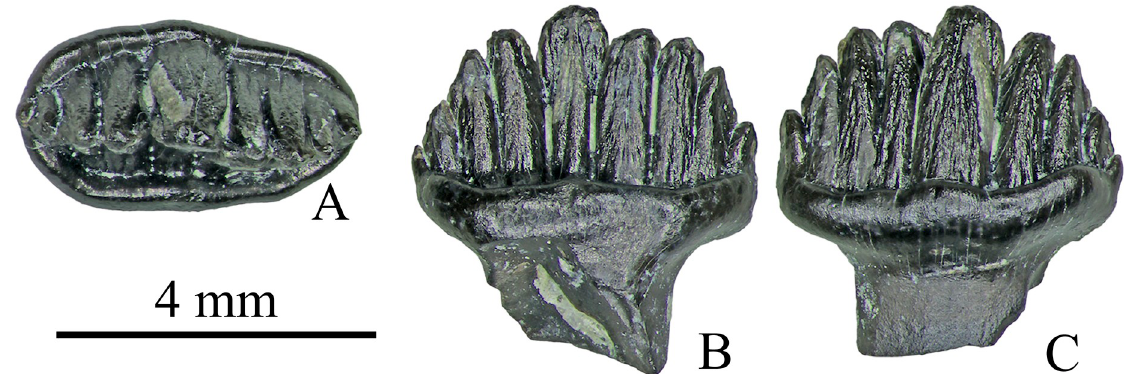
Fig 15. Small dentary tooth ZIN PH 33/246 of Stegosauria indet. from the Teete locality Yakutia, Russia; Batylykh Formation (Lower Cretaceous) in occlusal (A), labial (B) and lingual (C) views.